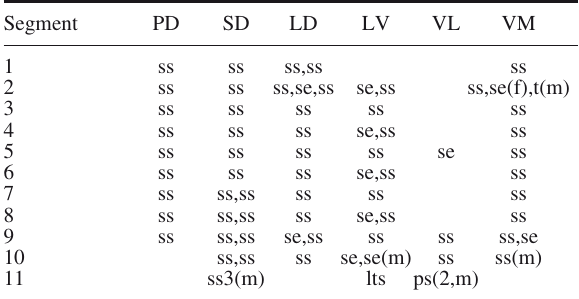
sexually dimorphic character; LD, laterodorsal; lts, lateral terminal spines; LV, lateroventral; m, male condition of sexually